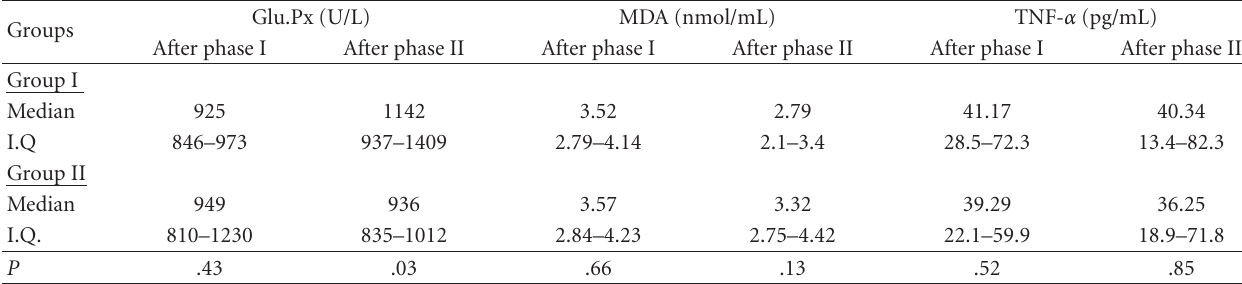
Table 1: Serum glutathione peroxidase (Glu.Px), malondialdehyde (MDA), and tumor necrosis factor- α (TNF- α ) in phases I and II of therapy for both leukemia groups.